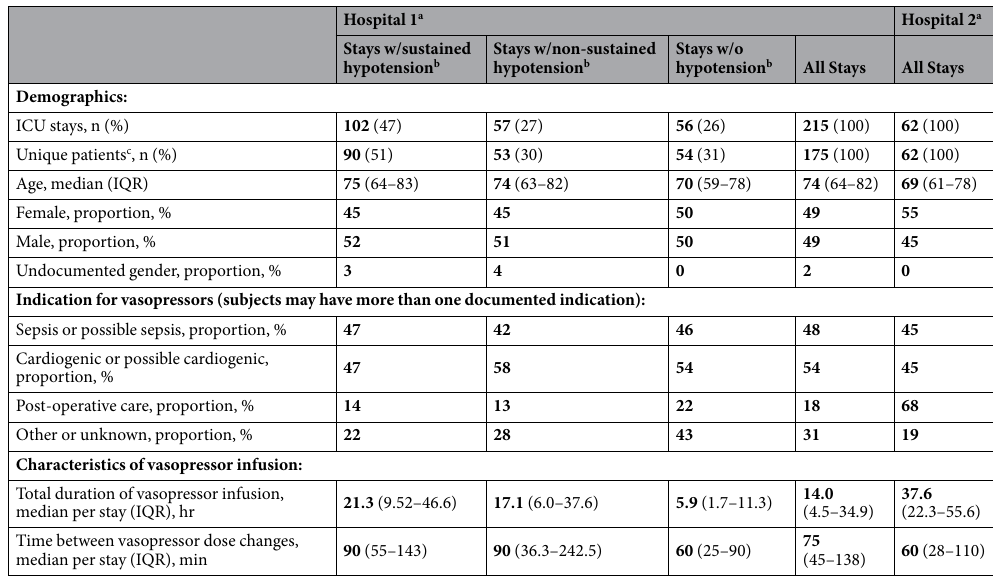
Table 1. Characteristics of intensive care unit stays. a Hospital 1 includes patient data from the MIMIC II database and Hospital 2 includes patient data from a separate medical center. b Hypotension is defined as MAP < 60 mmHg and sustained episode of hypotension is defined as at least 15 continuous min of hypotension. c Some patients have multiple stays that are in different categories, therefore the number of unique patients for all stays is less than the sum of the first three